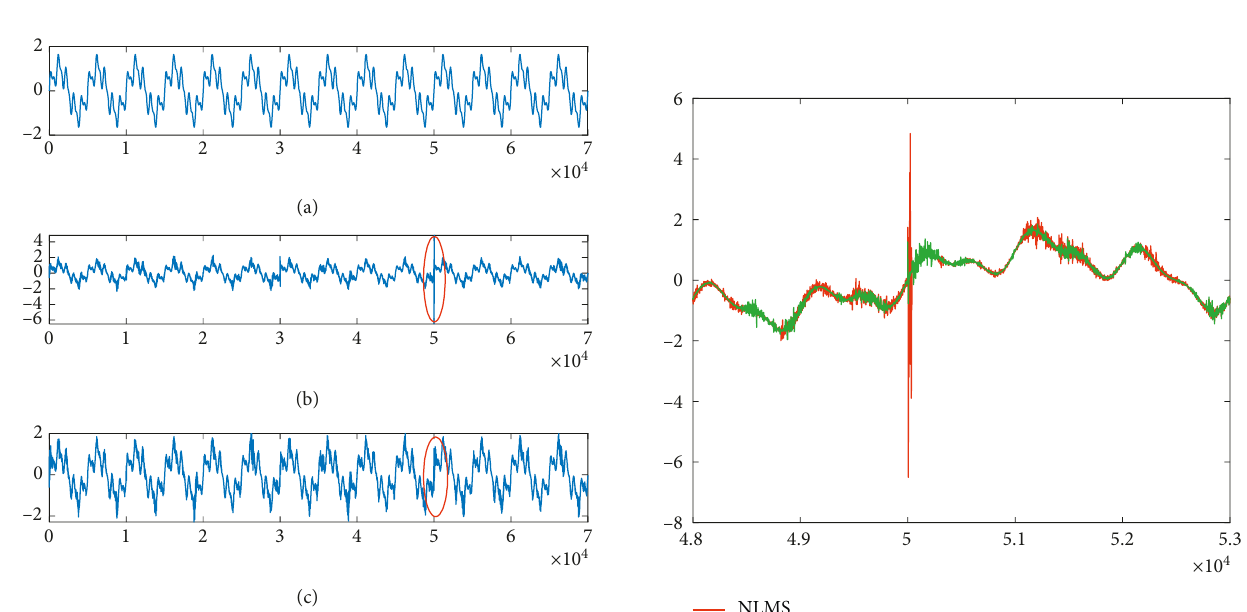
n . (b) Residual noise. ( )